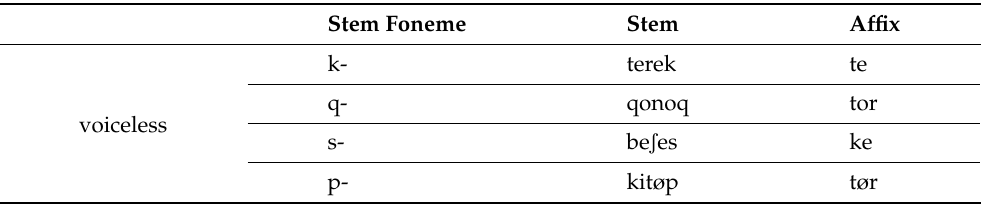
Table 5. Consonant harmony in Kirghiz stem and